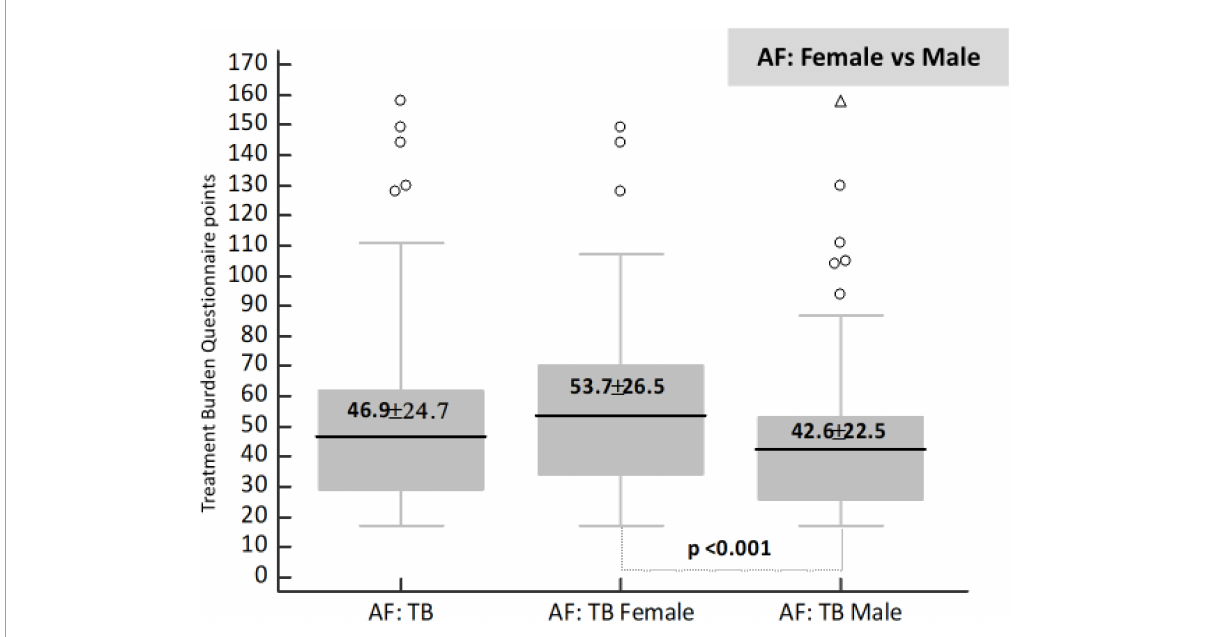
FIGURE2 Sex difference in treatment burden in whole and atrial fibrillation (AF) study cohort. TB, treatment burden; AF, atrial